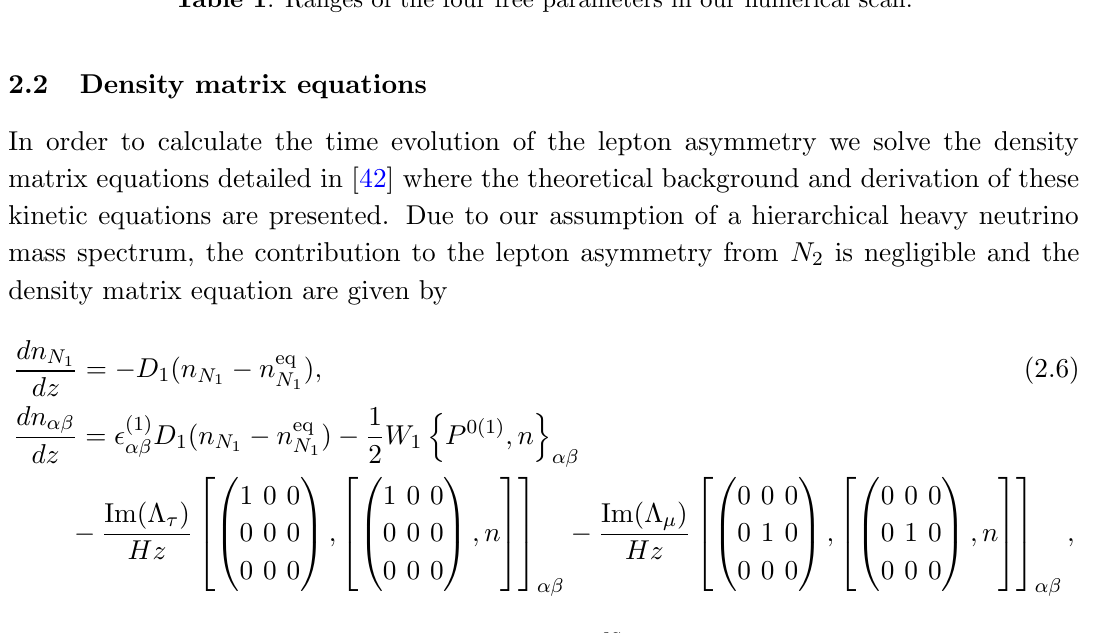
Table 1 . Ranges of the four free parameters in our numerical